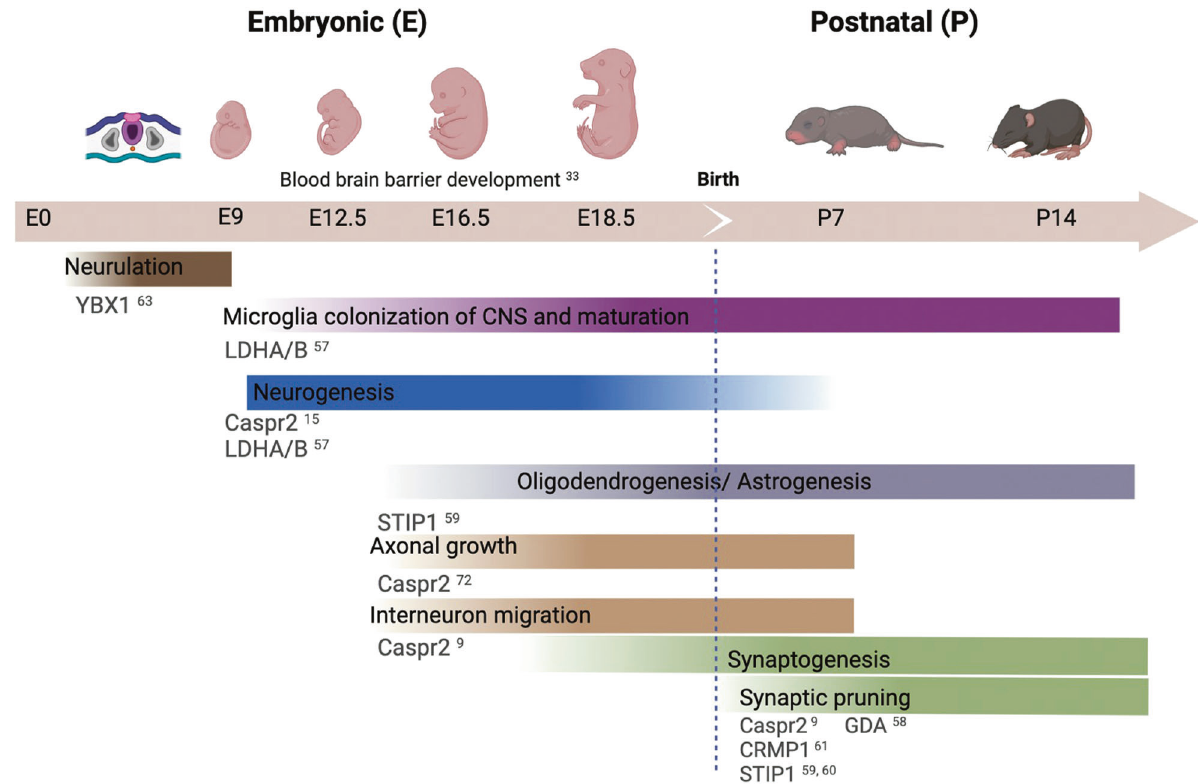
Fig. 2 Neurodevelopmental timeline of antigens targeted by Abs of mothers of a child with ASD. Schematic of processes occurring during prominent periods of embryonic and postnatal brain development in mice. The antigens hypothesized to be involved in the neurodevelopmental processes are listed in dark gray. Figure was created with